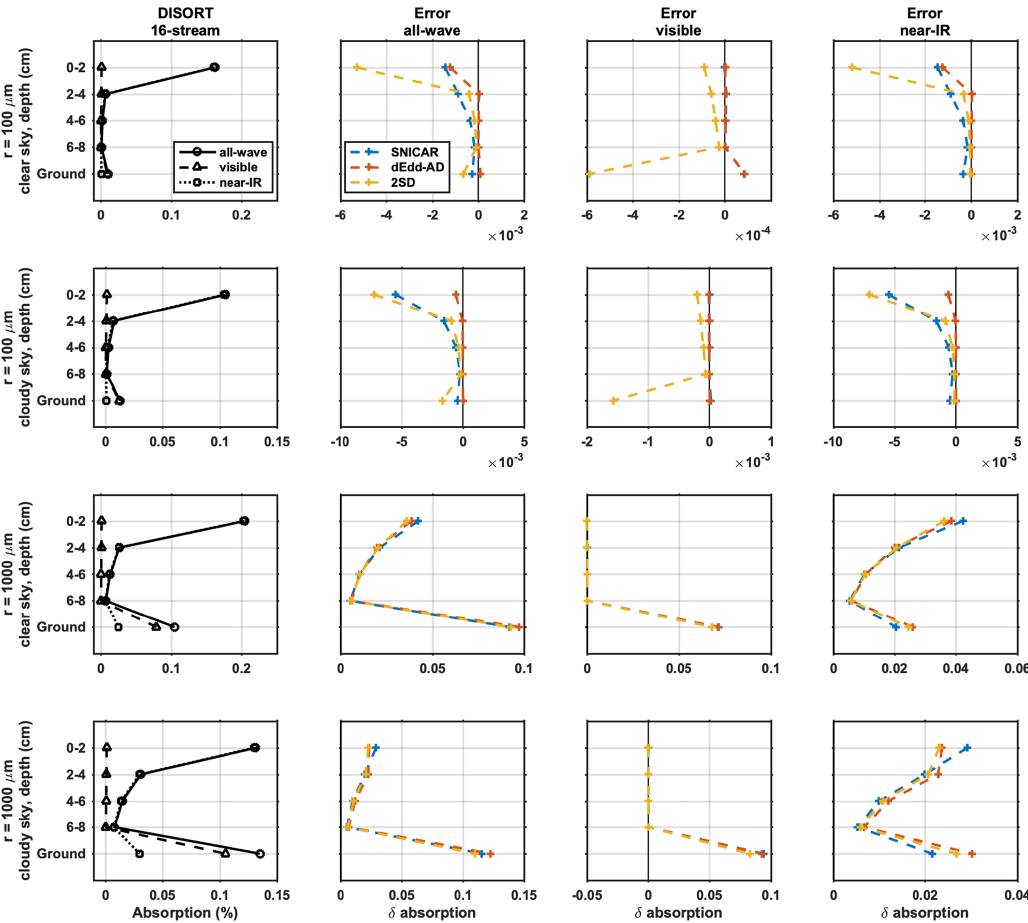
Figure 10. Comparison of light-absorption profiles derived from two-stream models and 16-stream DISORT. The left-most column shows fractional band absorptions computed using 16-stream DISORT. The right three panels show the errors of all-wave, visible, and near-IR fractional absorptions calculated using two-stream models. The top and bottom panels are for clear-sky and cloudy-sky conditions (solar zenith angle of 60 ◦ ), respectively. The snowpack is 10cm deep and is divided evenly into five 2cm thick layers, for new snow ( r = 100µm) and old snow ( r = 1000µm). Layers 1–4 represent the top four snow layers (top 8cm), and layer 5 represents underlying ground with an albedo of